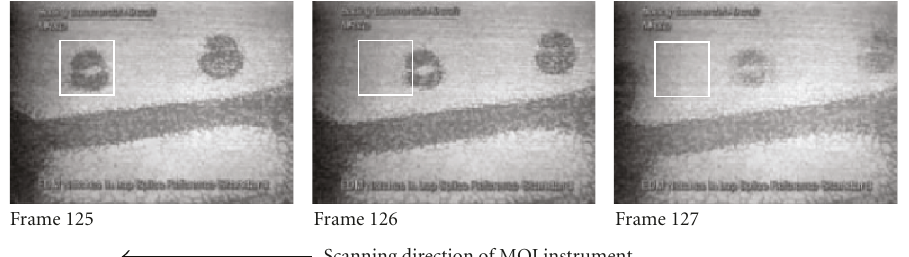
Figure 2: Three consecutive MOI images; dark disks represent rivets, which are moving to the right, while the sensor is moving to the left. Dark bands show a substrate seam into the airplane structure.